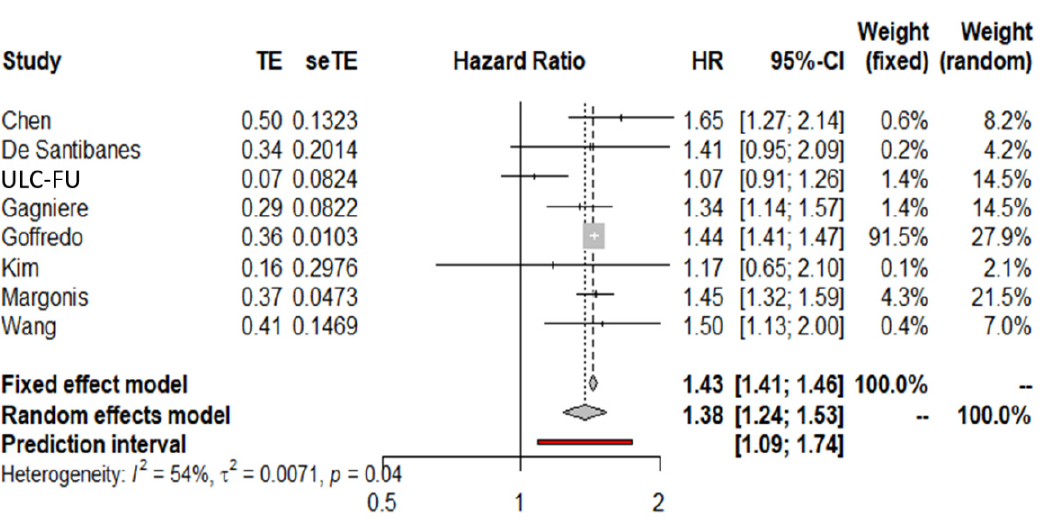
Figure 4. Forest plot for KRAS sidedness interaction terms (left includes rectal tumors).